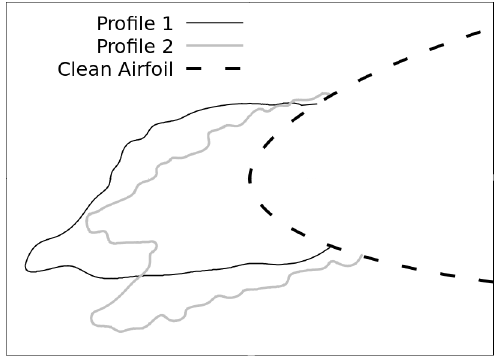
Figure 2. Ice profiles 1 and 2.